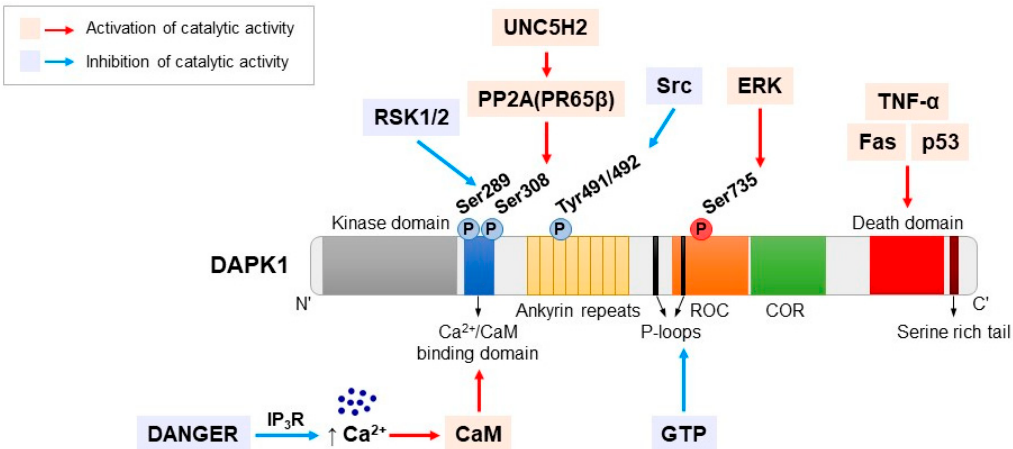
Figure 1. Schematic diagram of the structure of DAPK1. There are diverse molecules involved in the regulation of DAPK1 activity in neuronal cell death. The molecular mechanisms and function of DAPK1 can be regulated by multiple signals in variety of phosphorylation sites. DAPK1 activity is negatively regulated by its phosphorylation at Ser308 as well as Ser289 in the CaM autoregulatory domain and Tyr491 and Tyr492 in the ankyrin repeat domain (blue arrows). Moreover, the phosphorylation of Ser735 in the ROC-COR domain induces the catalytic activity of DAPK1 (red arrow). Furthermore, several interacting partners modify DAPK1 catalytic activity, protein-protein interactions, and pro-apoptotic activity. Phosphorylation sites in blue are negatively regulating and the one in red is activating DAPK1 activity.